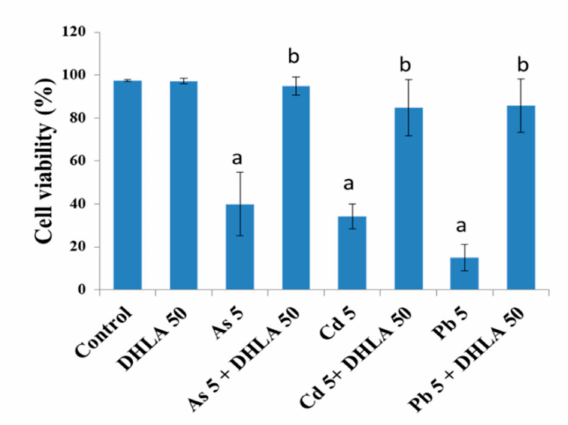
Figure 4. Cell viability of PC12 cells after treatment with toxic metals and/or DHLA for 48 h determined by trypan blue exclusion method. The values of the bars indicate the mean ± SEM ( n = 5). Here, “a” denotes a significant difference compared to the control group ( p < 0.05), and “b” denotes a significant difference compared to the associated metal group ( p <